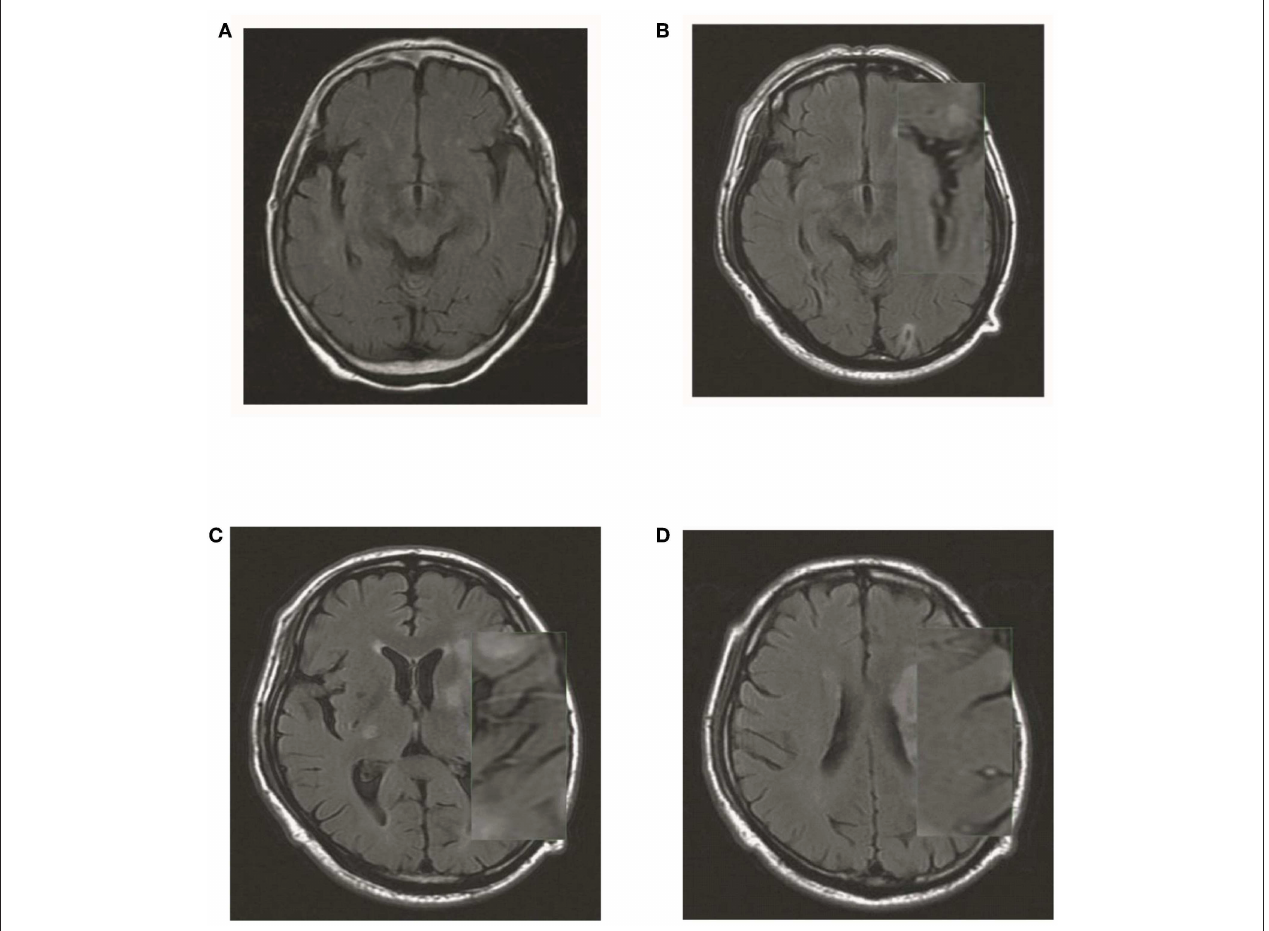
FIGURE 3 | Illustration of HVS quantification. (A) A score of 0 was defined as absence of HVS; (B) a score of 1 indicated HVS limited to the Sylvian fissure; (C) a score of 2 indicated HVS limited to the Sylvian fissure and the cerebral sulci of the temporal-occipital junction; and (D) a score of 3 indicated HVS that extended to the cerebral sulci of the fronto-parietal lobe in addition the locations indicated by a HVS score of 1 or 2.